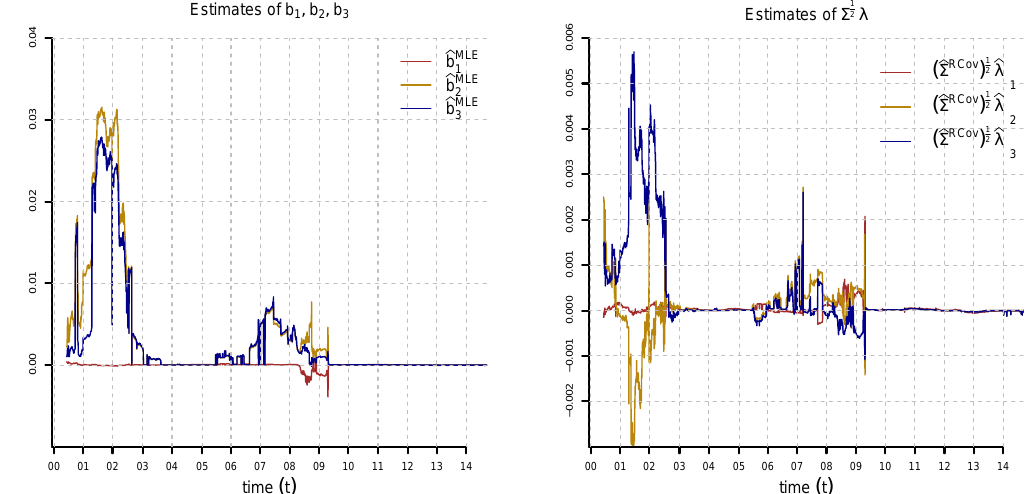
Figure 13. Estimation of b 1 , b 2 and b 3 (lhs) and ( Σ 1 2 λ ) 1 = b 1 − a 1 , ( Σ 1 2 λ ) 2 = b 2 − a 2 and = b − a ( Σ 1 2 λ ) 3 3 3 (rhs) by optimizations (23) and (24) in the three-factor model for K τ 1 = 1, τ 2 = 2, τ 3 = 5, τ 4 = 10, τ 5 = 21, τ 6 = 63, w ij = 1 { i = j } and S = 10 − 5 · 1 . The difference between b and a is considerable in 2000–2002 and 2006–2009.